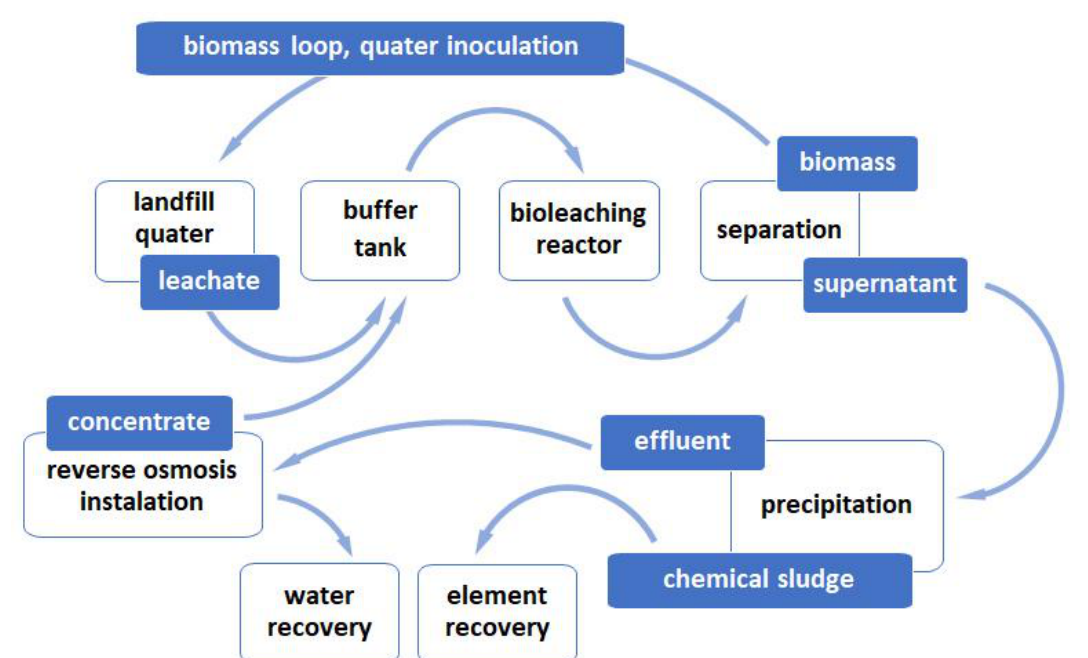
Figure 22. Scheme of an integrated solution for the treatment of landfill leachate.